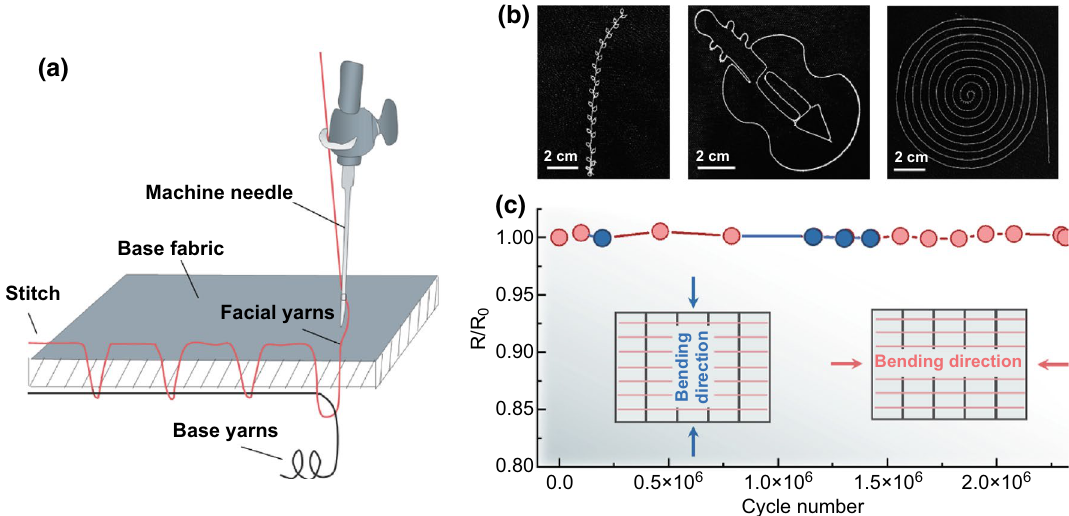
Fig. 6 Mechanized fabrication of SF/SSF and PTFEF/SSF textiles: a sketch map of the embroidery machine weaving yarns into fabric. b Differ- ent patterns of fabricated SF/SSF and PTFEF/SSF fabrics obtained using embroidery machine. c Resistance changes of the SSF in SF/SSF fabric during longtime cyclic deformations. The insets are diagrams of bending direction of SF/SSF textiles during deformations (bending direction along with the